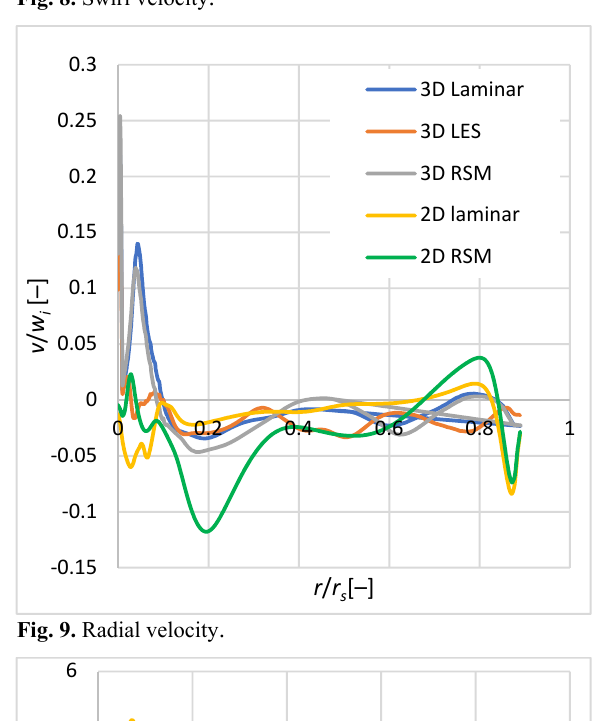
Fig. 9. Radial velocity .